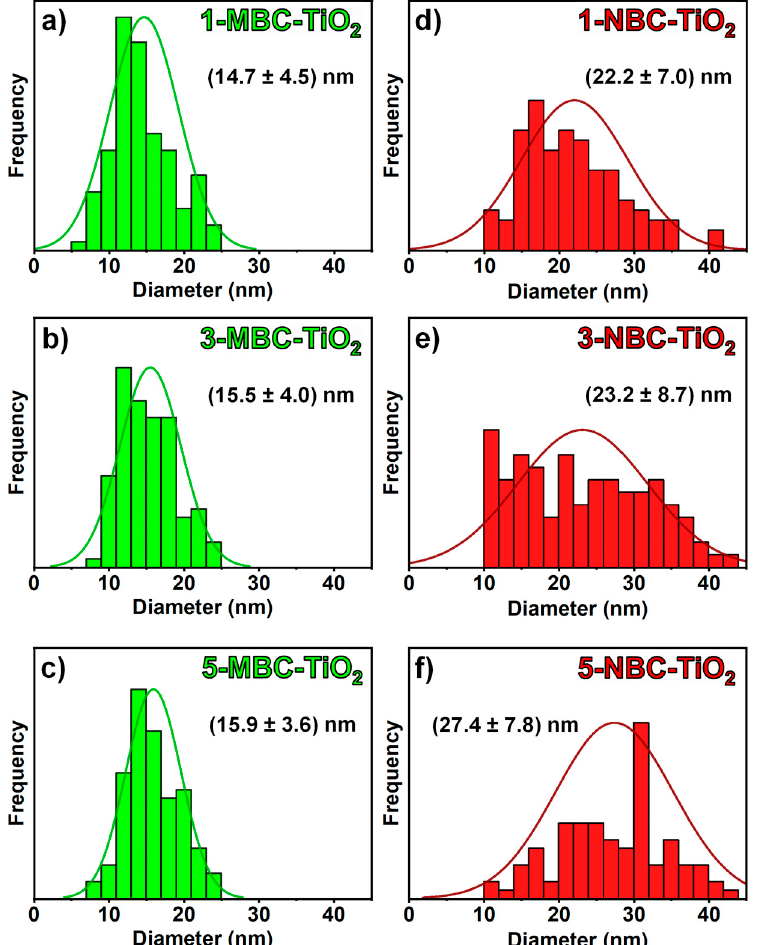
Figure 5. Size distributions of BC NPs in samples after ( a , d ) 1, ( b , e ) 3, ( c , f ) and 5 depositions. 7-NBC-TiO 2 and 7-MBC-TiO 2 samples were not considered in this morphological evaluation owing to the impossibility of identifying well-defined NPs due to the formation of agglomerated carbonaceous film. Refer to Figure 4 for SEM images of these samples.